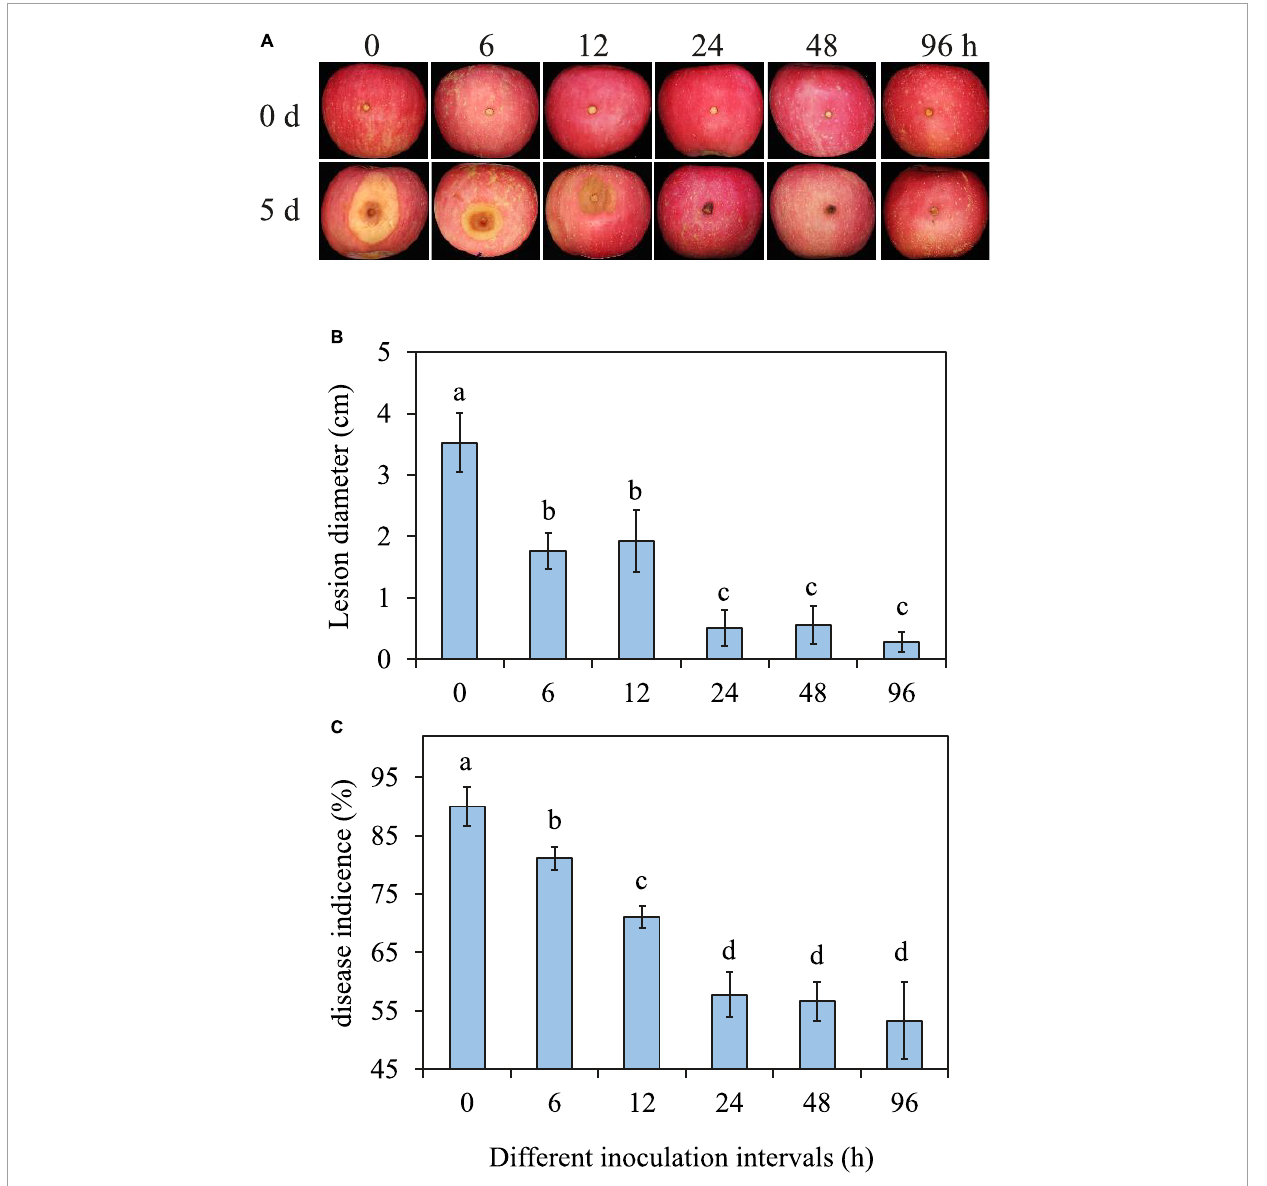
FIGURE2 Effects of P. syringae B-1 with different inoculation intervals at 1 × 10 8 CFU mL– 1 on the disease symptoms (A) , lesion diameter (B) , and disease incidence (C) in inoculated apple fruit at 5 dpi. Error bars represent the SD of three replicates. Different letters above the bars indicate significant differences ( p < 0.05) between the different inoculation